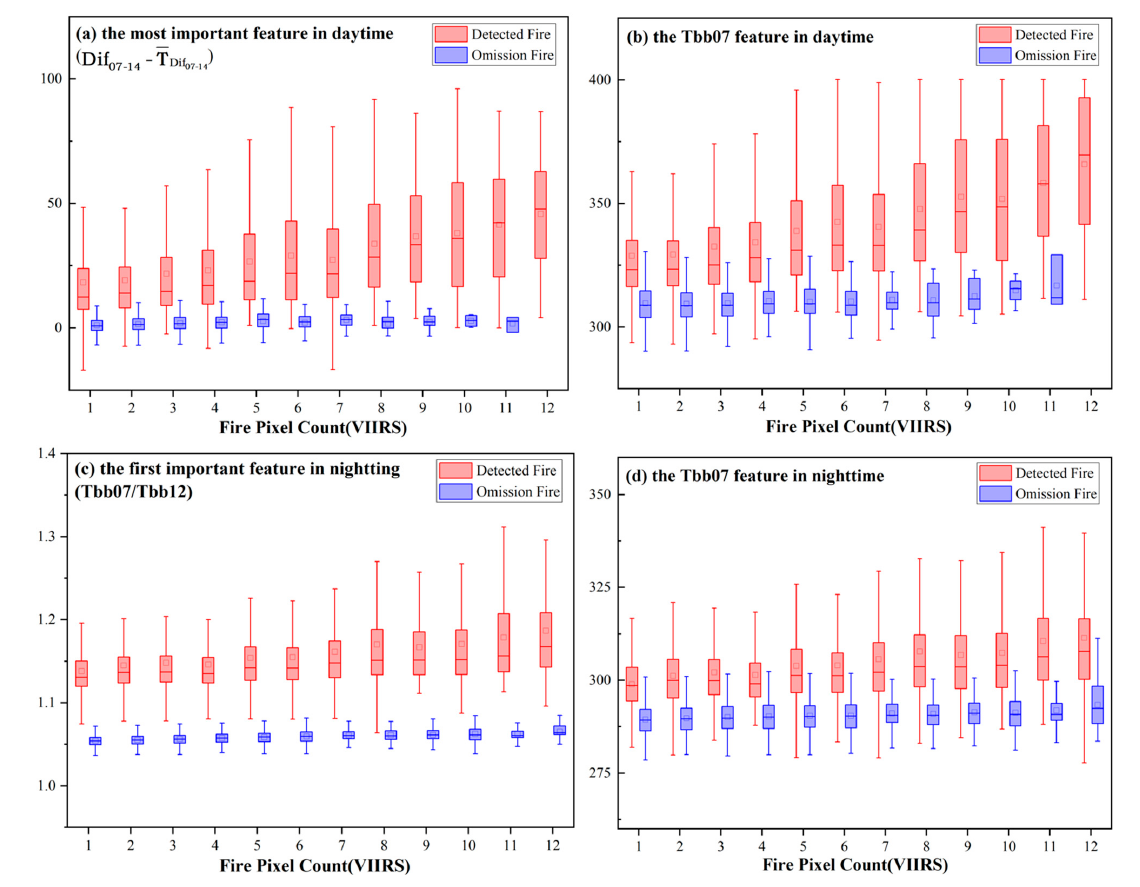
Figure 9. Distribution of detection fire pixels and omission fire pixels for the RF-D and RF-N models for the first ranked feature and the Tbb07 feature for different fire pixel counts. ( a , b ) show the distributions of the Dif 07–14 − T Dif feature and Tbb07 feature for daytime fire pixels, respectively; ( c , d ) show the distributions of the Tbb07/Tbb12 feature and the Tbb07 feature for nighttime fire pixels, respectively. Note that there are no omission fire pixels at the daytime fire pixel count of 12.